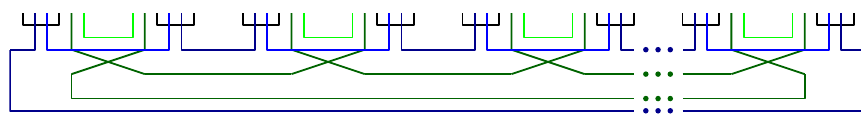
Figure 3 . The representation of the density matrix graphically.